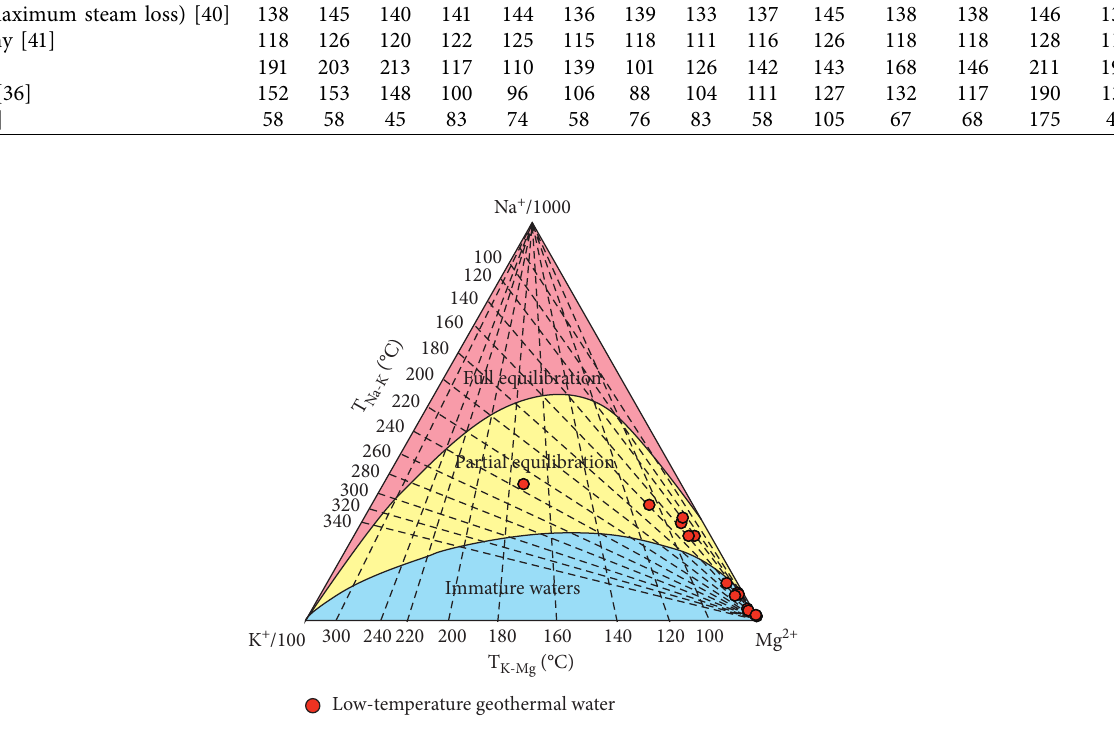
Figure 6: Graphical evaluation of water-rock equilibration temperatures for geothermal waters using Na-K-Mg concentrations in “mg/L” [38].